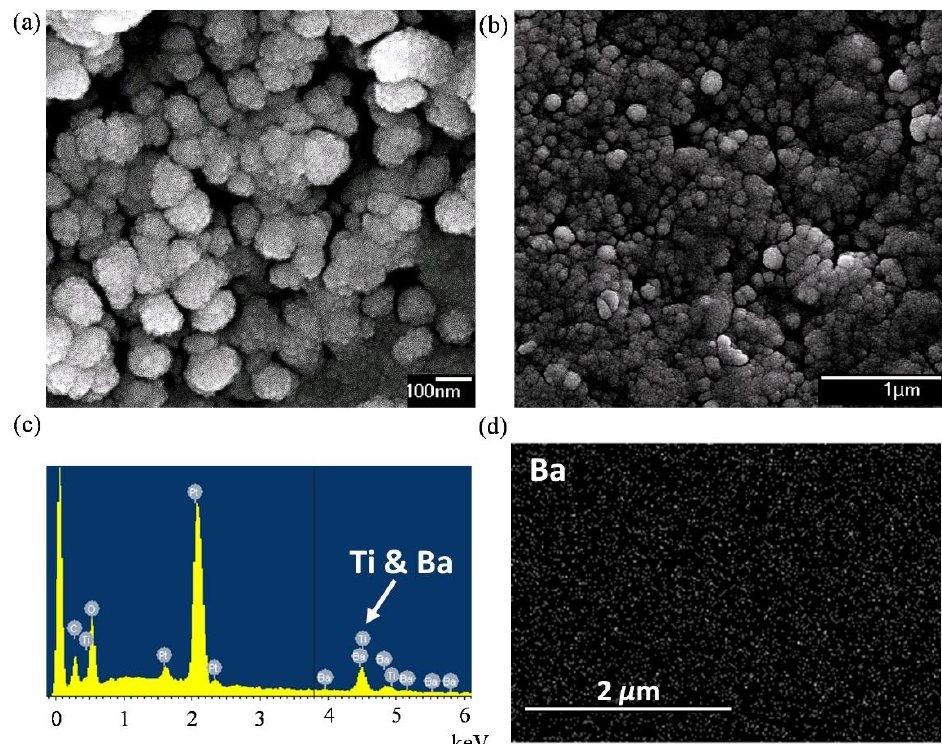
Figure 2. SEM images of ( a ) pure BaTiO 3 nanopowders and ( b ) 25 vol. % BaTiO 3 –epoxy nanocom- posite. ( c ) EDS of 25 vol. % sample and ( d ) the corresponding Barium distribution using EDS map-